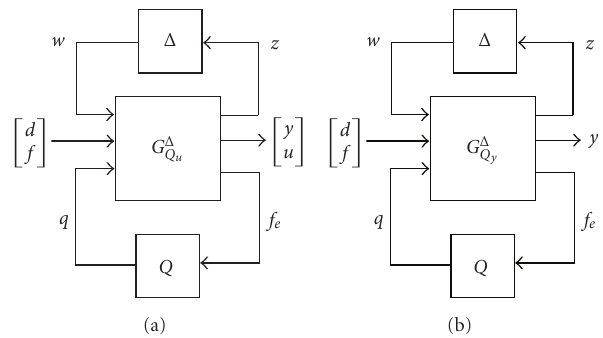
Figure 7: LFT formulations for compensator Q under model un- certainty: (a) control signal and output attenuation, and (b) output signal